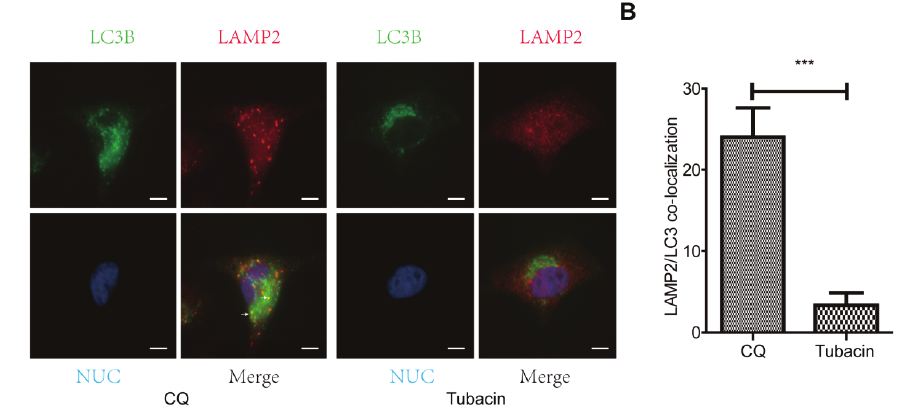
Figure 4: Tubacin treatment blocked the fusion of autophagosome and lysosome. (a) U251 cells were treated with CQ (25μM) or tubacin (2nM) for 8 hours followed by immunofluorescence. Autophagosome was detected by LC3B antibody combined with CF488-conjugated goat-anti-rabbit antibody (green). Lysosome was detected by LAMP2 antibody combined with CF568-conjugated goat-anti-mouse antibody (rabbit). Scale bars, 10 μM. (b) Fused puncta, which indicated fused autolysosome, in 30 cells were obtained for statistical